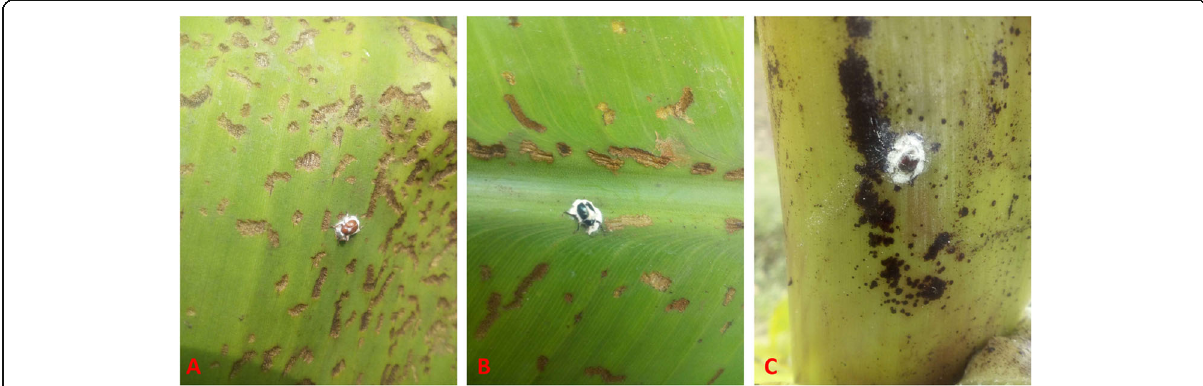
Fig. 2 Effect of EPF native isolates on Basilepta subcastata after 8 days of inoculation. a Insect cadaver fully covered with bright white mycelia of Beauveria brongniartii . b Insect cadaver fully covered with mycelium of Metarhizium pinghaense . c Insect cadaver covered with conidia of Metarhizium